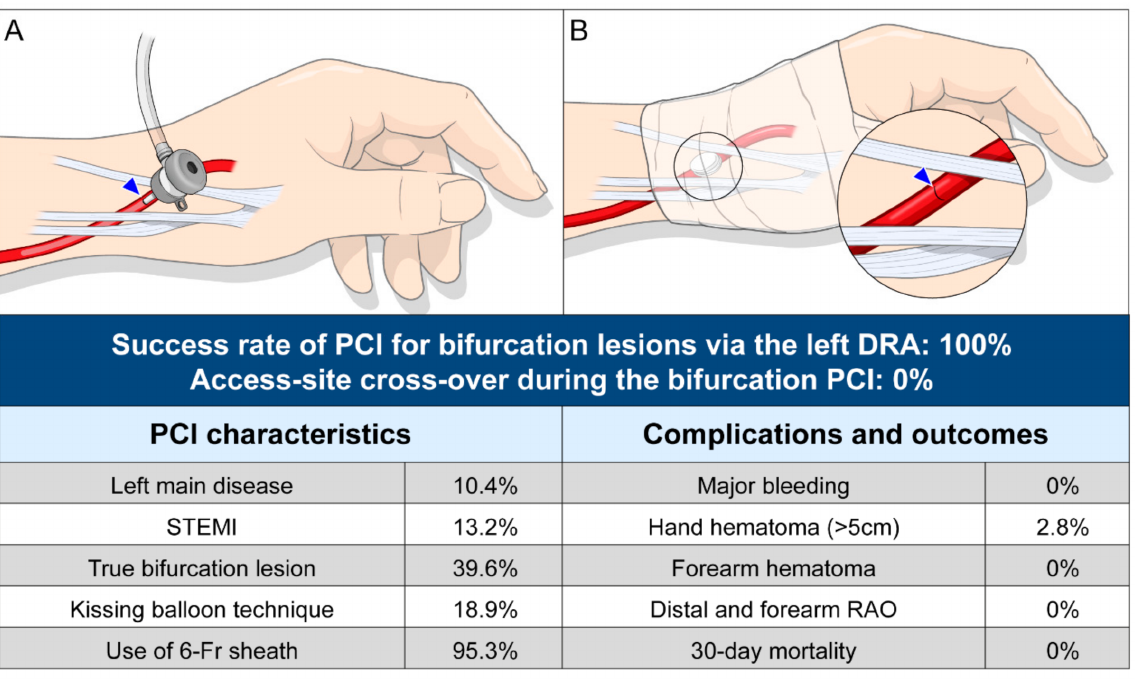
Figure 3. Inserted 6-Fr sheath via the left distal radial artery in the anatomical snuffbox area (blue arrowhead: puncture site) ( A ) and dressing for hemostasis with compressive bandage with gauze ( B ) and summary of the study outcomes. Abbreviations: DRA, distal radial approach; PCI, percutaneous coronary intervention, RAO, radial artery occlusion; STEMI, ST-elevation myocardial infarction; Fr,